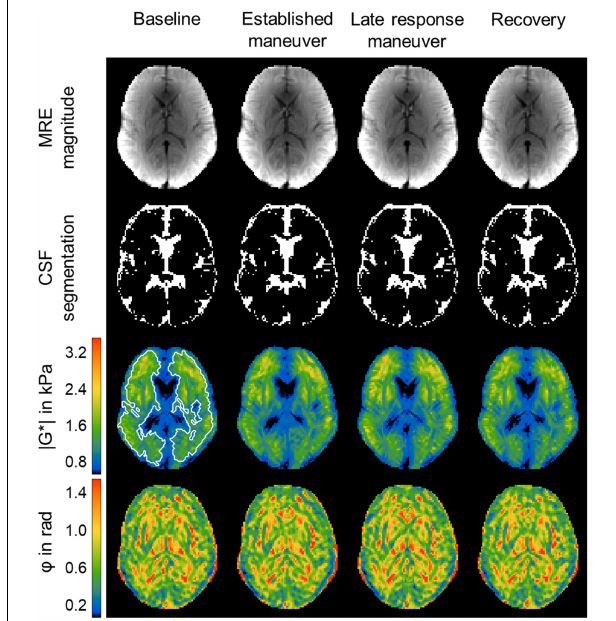
FIGURE 4 | Representative rt-MMRE MRE magnitude, CSF masks, | G*| and ϕ maps of the in vivo human brain. Time-averaged MRE magnitude, derived CSF masks, | G*| and ϕ maps of one volunteer over the four phases [baseline (BSL), established maneuver (ESM), late response maneuver (LRM) and recovery (REC)] of the VM experiment using the 31-Hz regimen (30.03, 30.91, 31.8 Hz). The number of CSF associated voxels for each phase was BSL: 1079, ESM: 1128, LRM: 1069, REC: 1074. The | G*| maps show slightly elevated values throughout the slice. The region of interest (ROI) is indicated by white lines. The same ROI was used for all phases and for the ϕ maps as